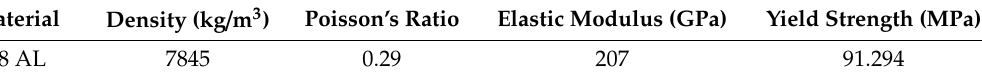
Table 1. Mechanical properties of 08 AL.